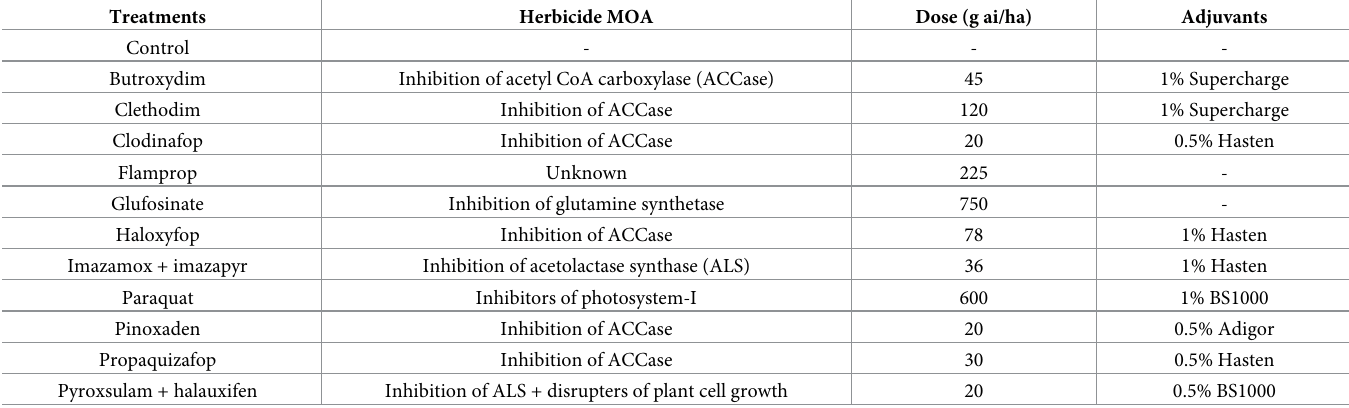
Table 1. Post-emergence herbicides, their recommended doses, and adjuvants used to spray Avena fatua and A . ludoviciana at two growth stages (small plants: 3–4 leaf stage; large plants: 6–7 leaf stage).